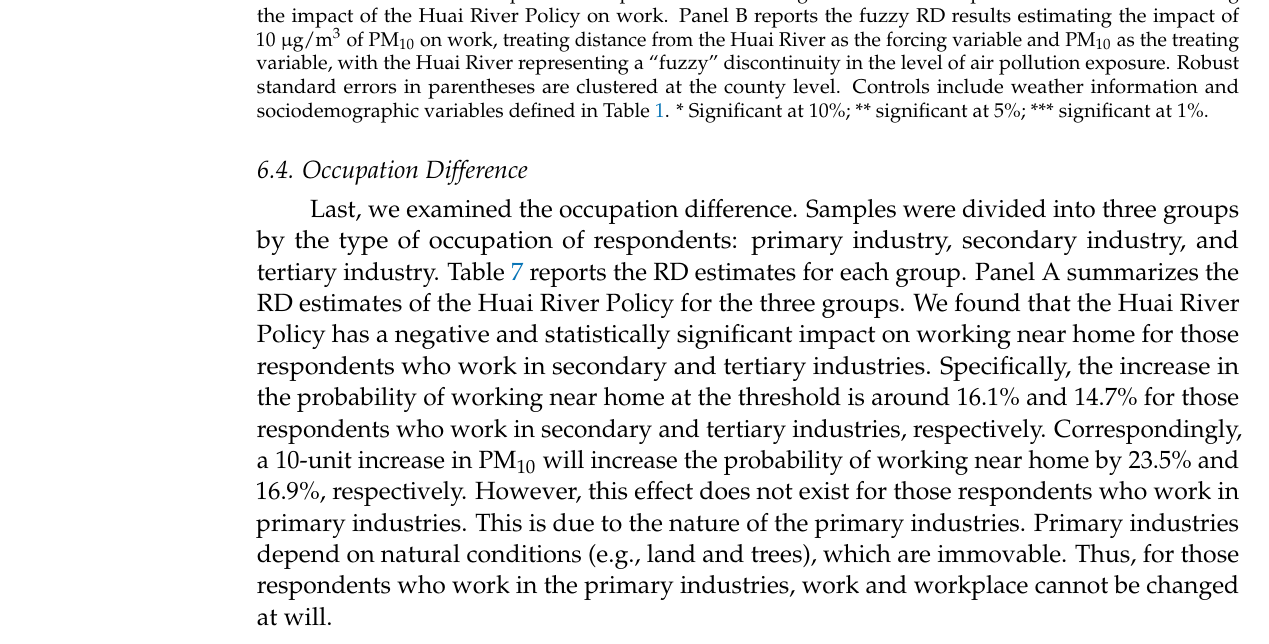
Table 7. The impacts of PM 10 on work by